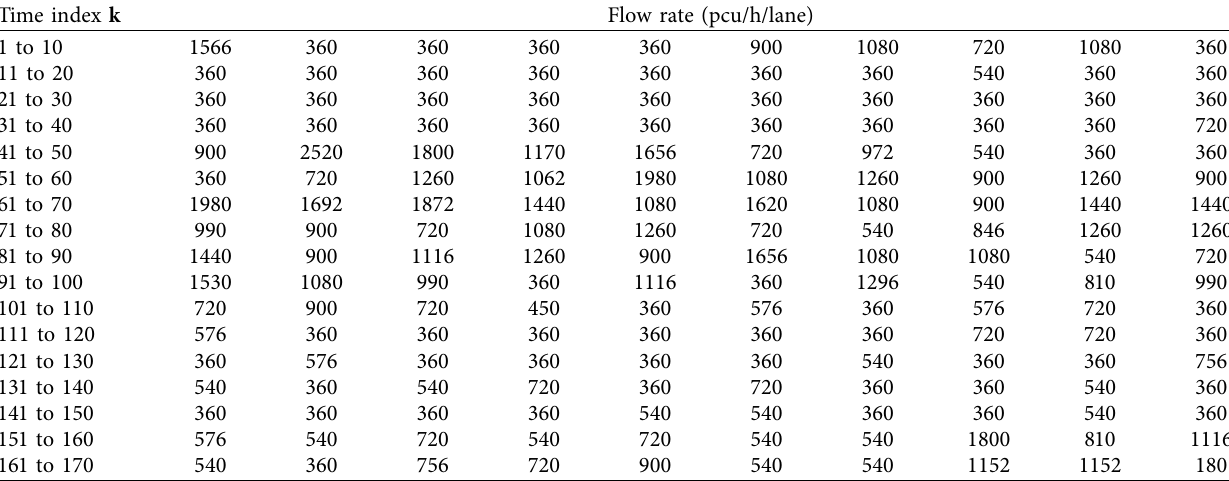
Table 2: Traffic volume of auxiliary